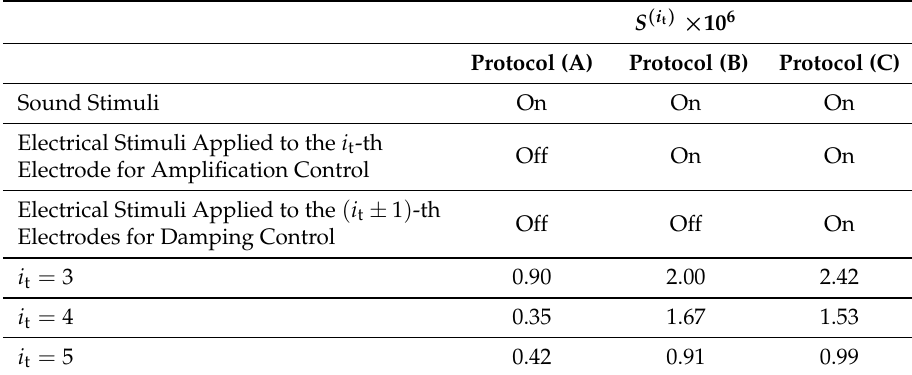
Table 1. Response factor S ( i t ) for protocols (A), (B), and (C) with i t = 3, 4, and